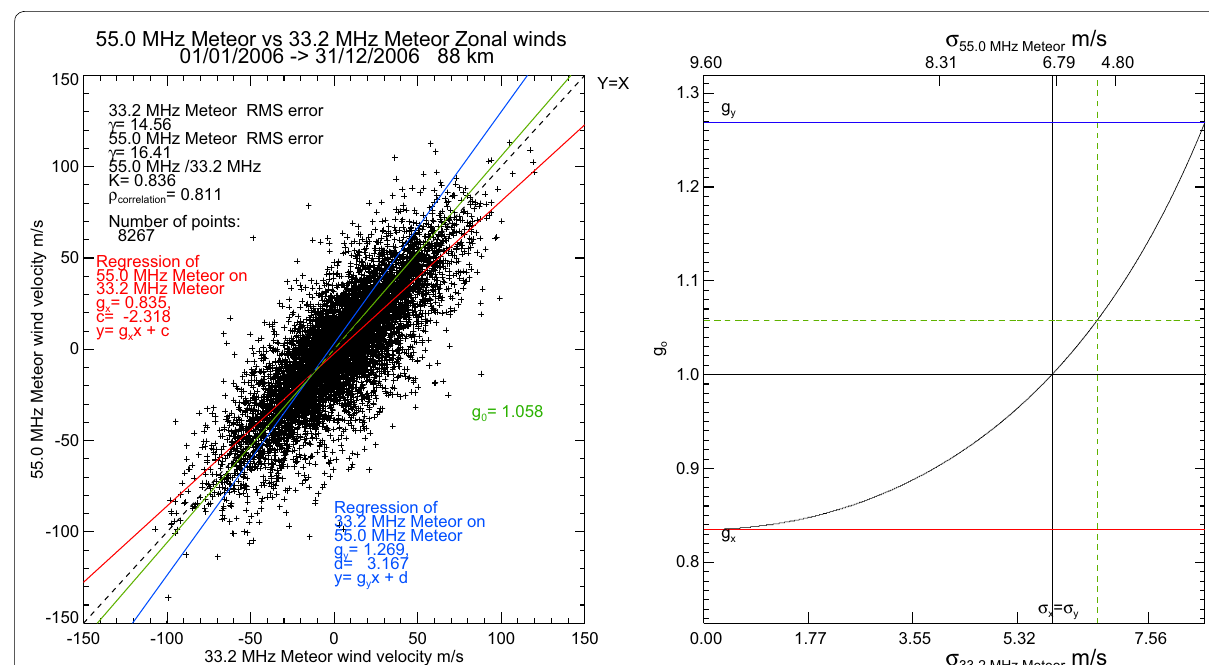
Fig. 2 An example scatter plot for hourly averaged zonal winds for a height of 88 km for 2006 measured with the two meteor radars (left) with the graphical solution for σ x , σ y , and g 0 (right). In the right-hand panel, the curve is bounded by the results of the regression fits and hence shows the upper limits on the error quantities associated with the random noise variances. The horizontal blue and red lines in the right-hand panel show the bounded region of possible solutions for g 0 that are determined by g x (red solution) and g y (blue solution) from the first plot. The green line in the left-hand plot is a total least squares regression fit to the data which assumes nothing about the errors in the results from each radar. It lies close to, but not on the y x line, suggesting the errors are not equal, but similar. For further details, see the =